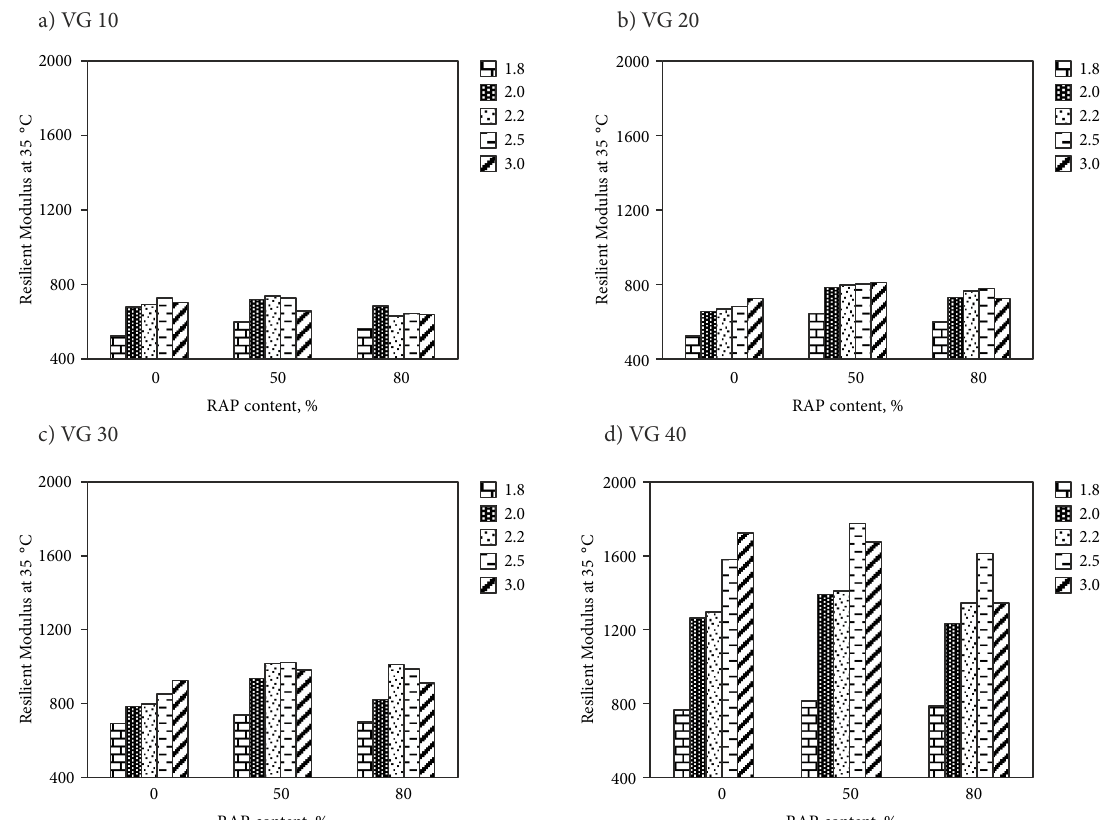
Figure 7. Variation of Resilient Modulus with Reclaimed Asphalt Pavement percentage and Foamed Bitumen Content at 35